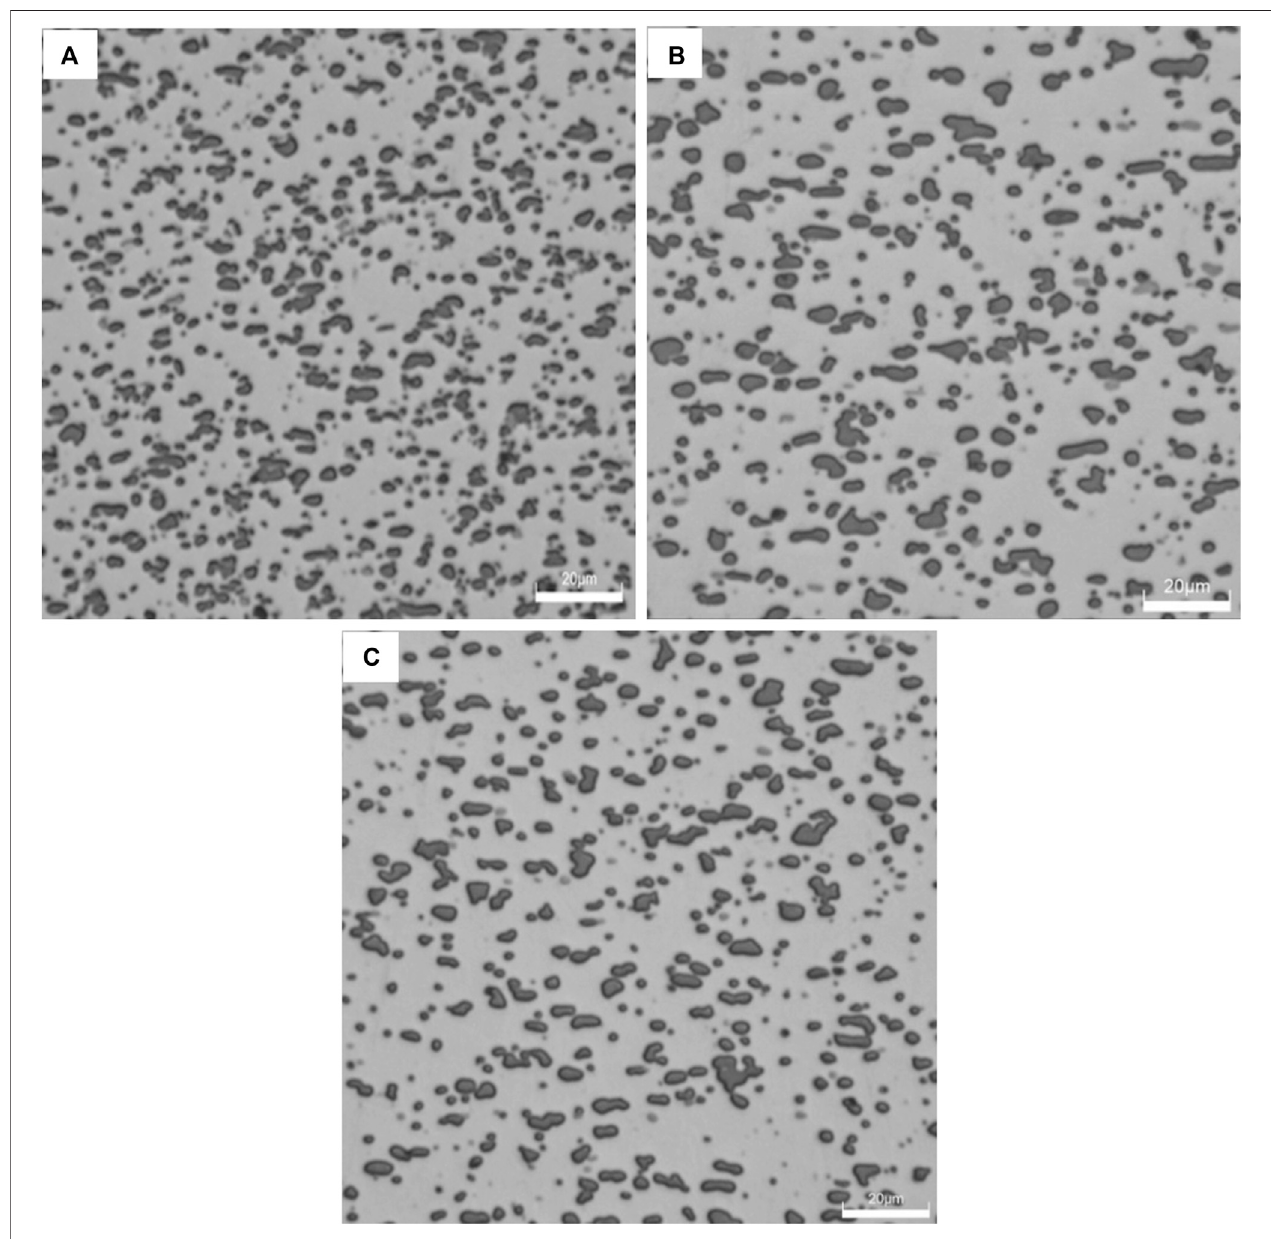
FIGURE 2 | The optimal microstructure of the alloy in different conditions, (A) T1, (B) T4, (C) T6.